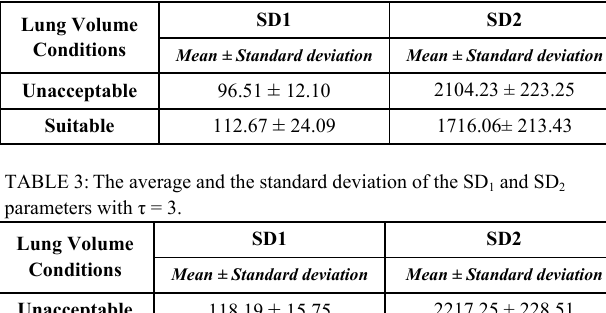
TABLE 2: The average and the standard deviation of the SD 1 and SD 2 parameters with τ = 2.